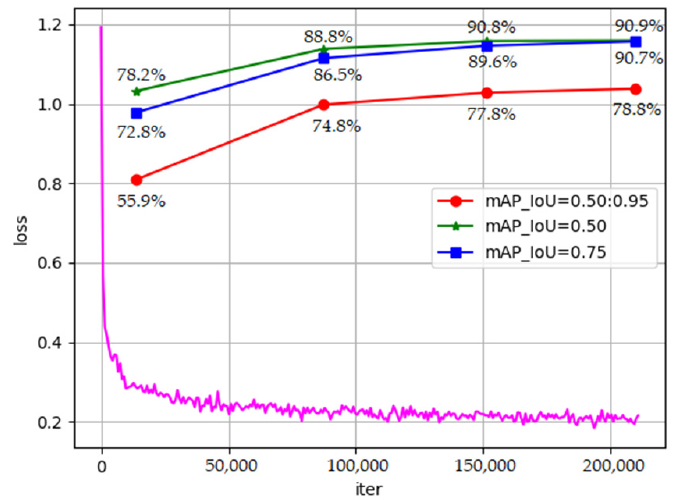
Figure 6. Training process and loss changes.